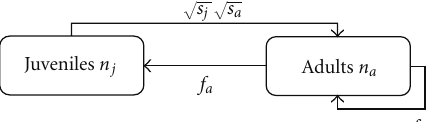
Figure 3: Two-stage life cycle graph for females. Animals spend one year in the juvenile stage before reaching maturity at the end of their second